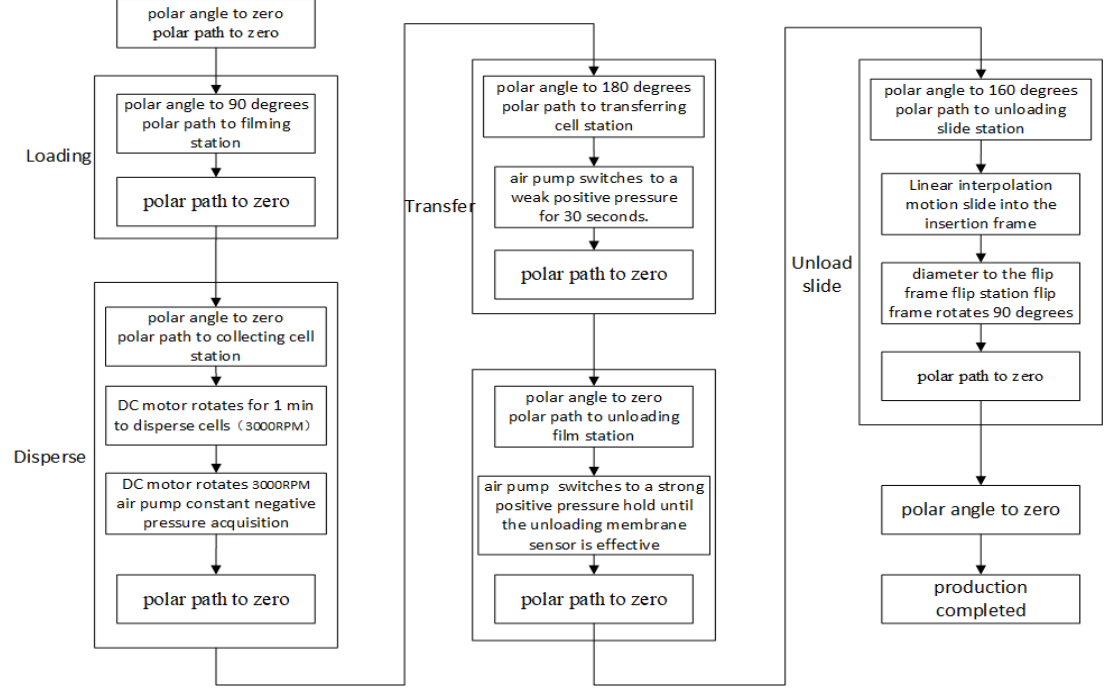
Figure 8. Production flow chart.